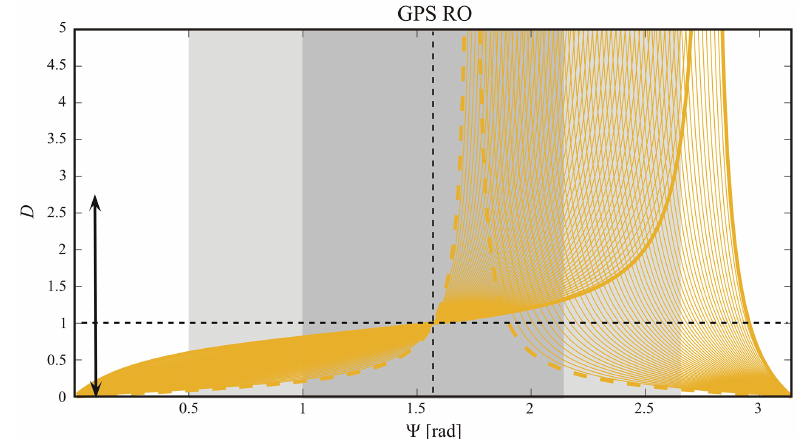
Figure 7. The yellow curves represent progressive and constant selected α values (step (cid:49)α = 0 . 02rad). They are selected within the allowed bounds [0.17–1.22] rad in the D – ψ GPS RO region, according to Fig. 5. These lower and higher bounds are indicated by thick dotted and full lines, respectively. White, light grey and grey sectors roughly indicate the non-hydrostatic, hydrostatic non-rotating and hydrostatic rotating GW regimes. Both quadrants are separated by the vertical dashed curve. The black double arrow indicates an hypothetical dominant non-hydrostatic GW that may be observed at different α directions, from different GPS-LEO satellite pairs. The “forbidden GPS-LEO RO sectors” are any sectors excepting those covered by yellow